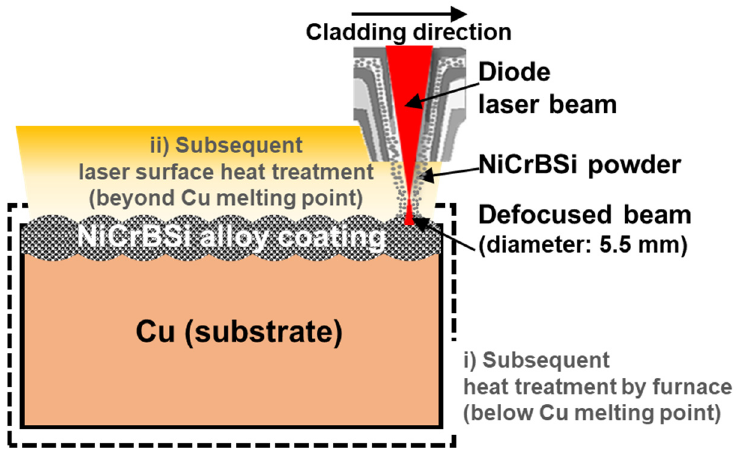
Figure 1. Schematic description of the laser cladding and post-clad heat treatment methods (furnace and laser heat treatment).